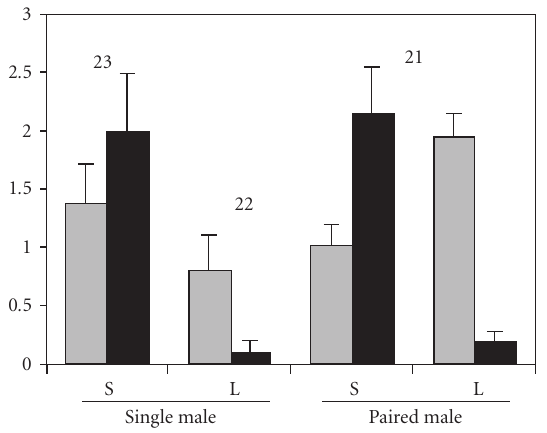
Figure 1: Number of copulation attempts (grey bar) and copulation rejections (black bar) for each treatment (mean ± SE). Sample size of the observed copulations is shown at the upper part of each bar.